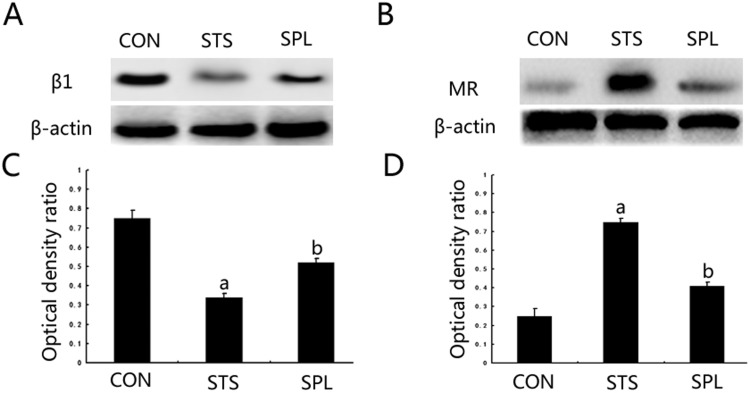
Spironolactone functioned in MR and integrin β1 expression of podocytes exposed to mechanical stress(A) Expression changes of protein MR. (B) Expression changes of protein integrin β1. (C and D) The intensities of the bands for MR and integrin β1 protein in (A) and (B) were quantified. aP< 0.05 compared with Group CON; bP< 0.05 compared with Group STS (n=6).